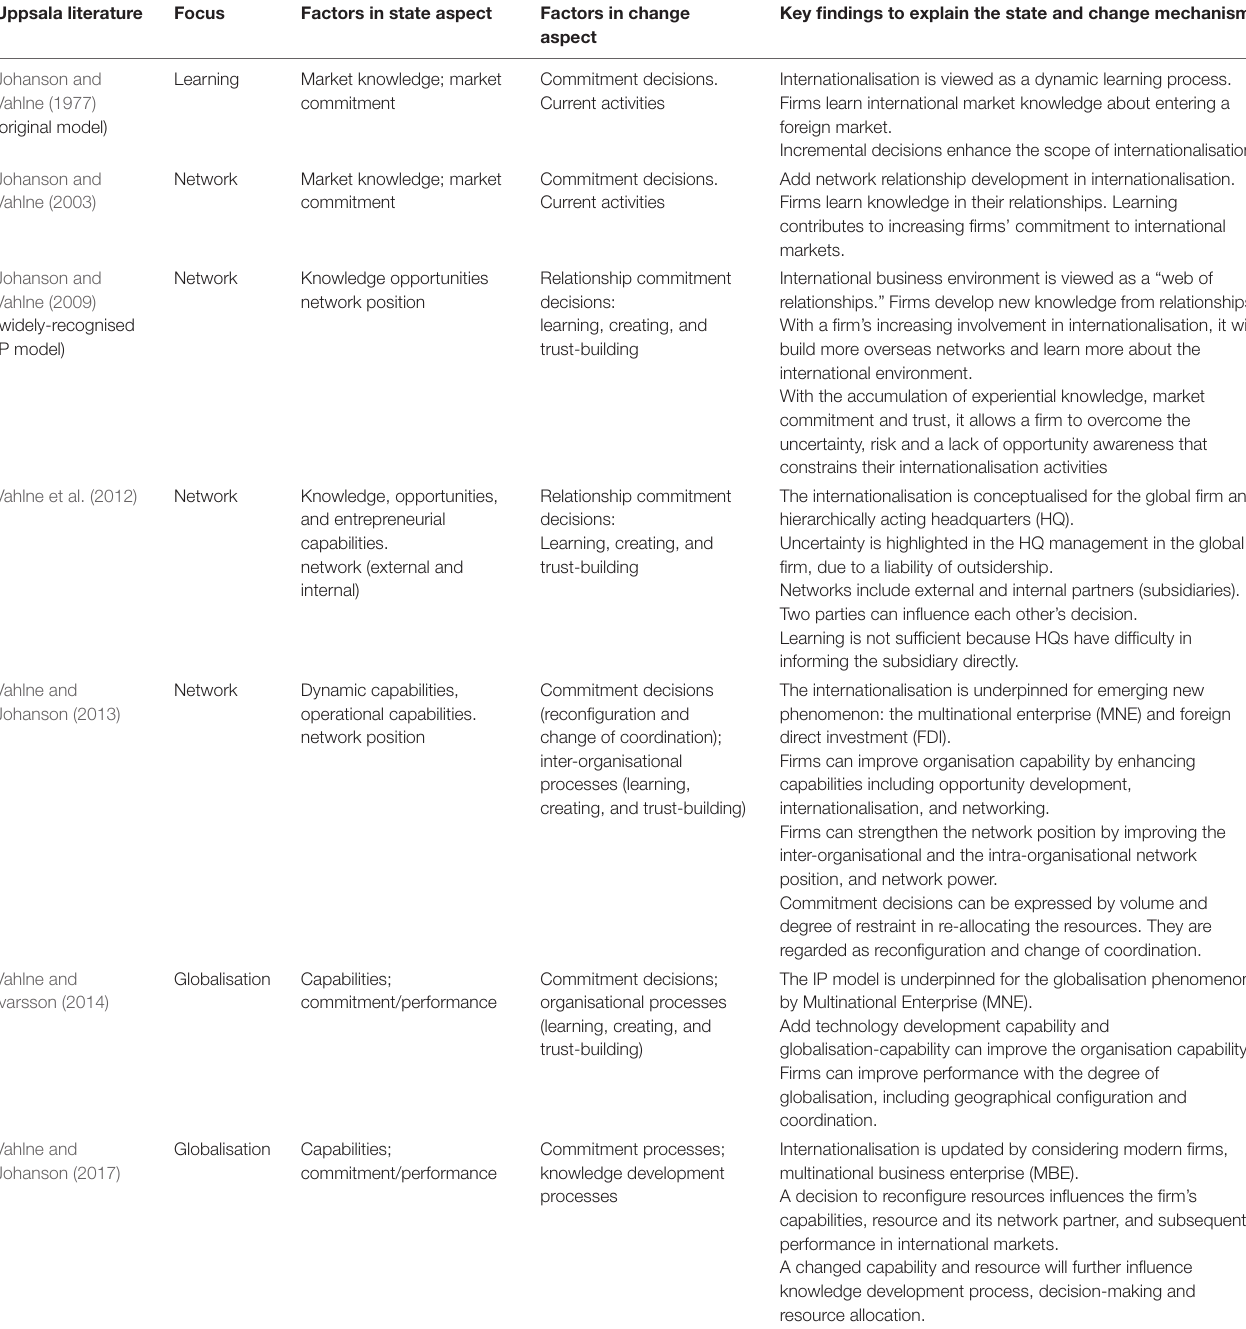
TABLE 1 | Evolution of the process of internationalisation (IP)